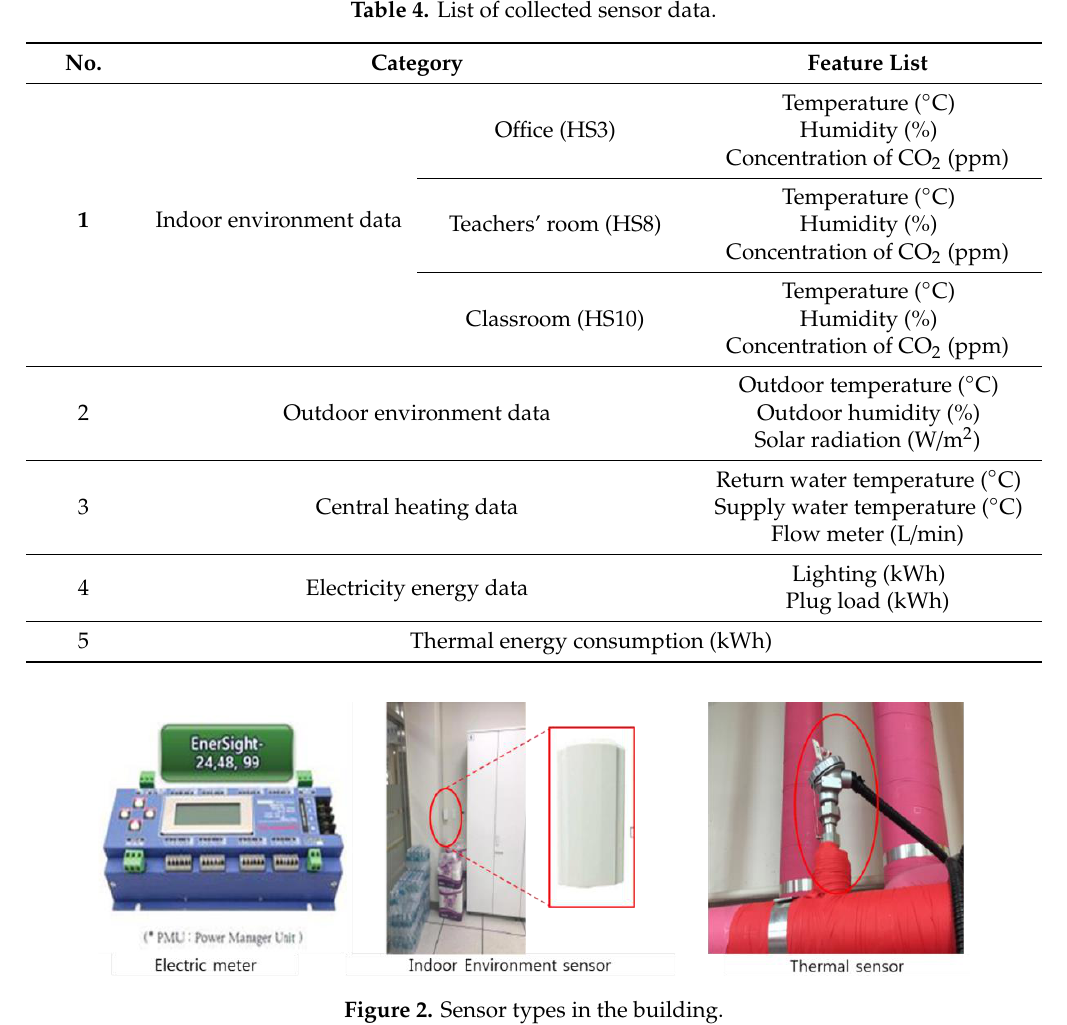
Figure 2. Sensor types in the building.